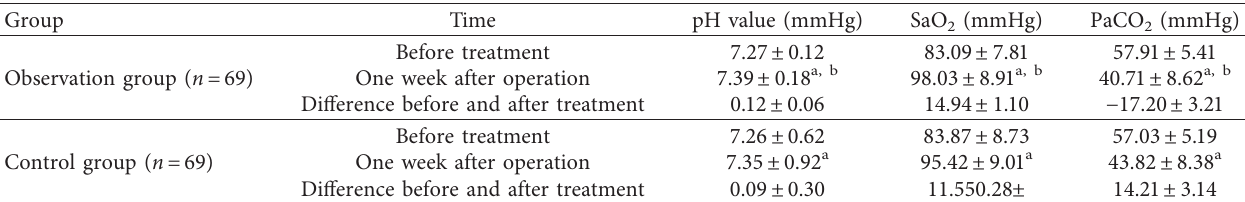
Table 2: Comparison of blood gas analysis indexes between the two groups ( x ± s , %).